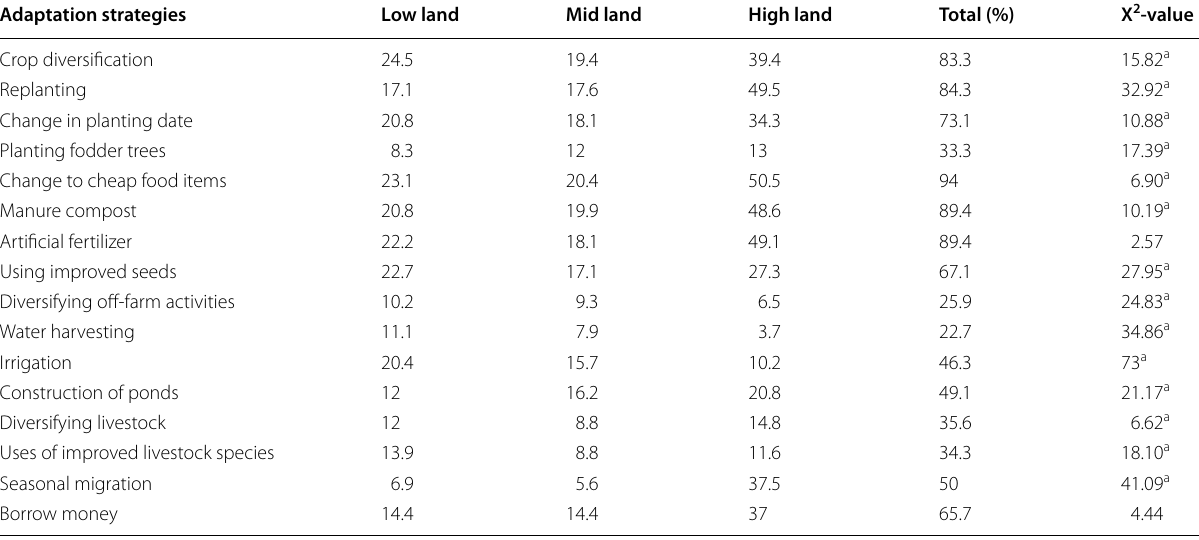
a Significant at p < 0.01, 0.05 and 0.1, respectively